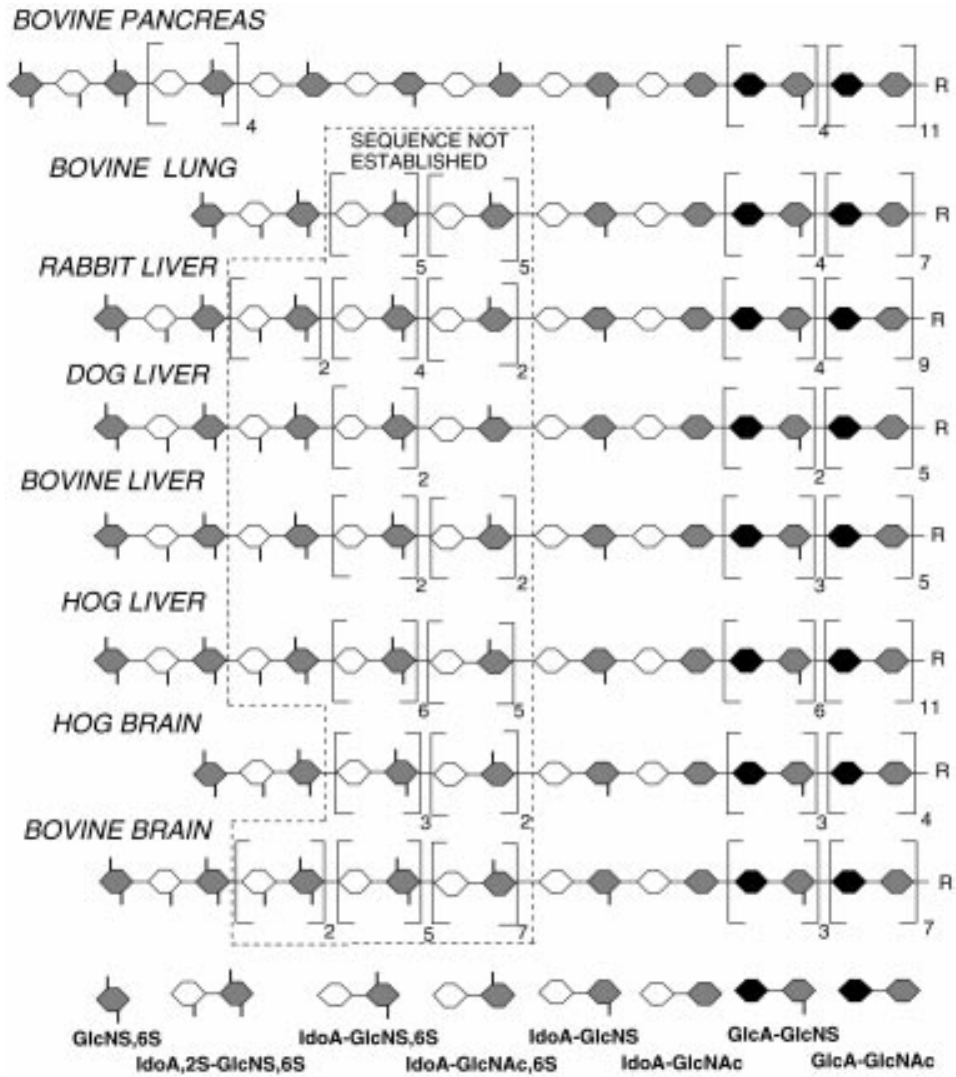
Figure 1 - Proposed structures of heparan sulfates from differ- ent mammalian tissues. R, Pro- tein linkage region. IdoA, a -L- Iduronic acid; GlcA, ß-D-glucu- ronic acid; GlcN, a -D-glu- cosamine; GlcNAc, a -D-N-acetyl- glucosamine; S,